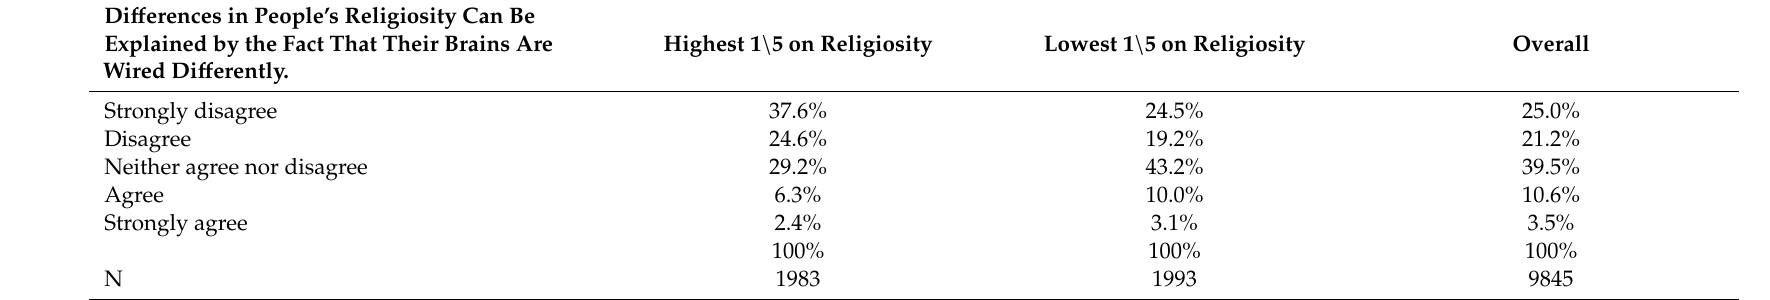
Table 3. Attitudes about Brain Wiring Explaining Religiosity by